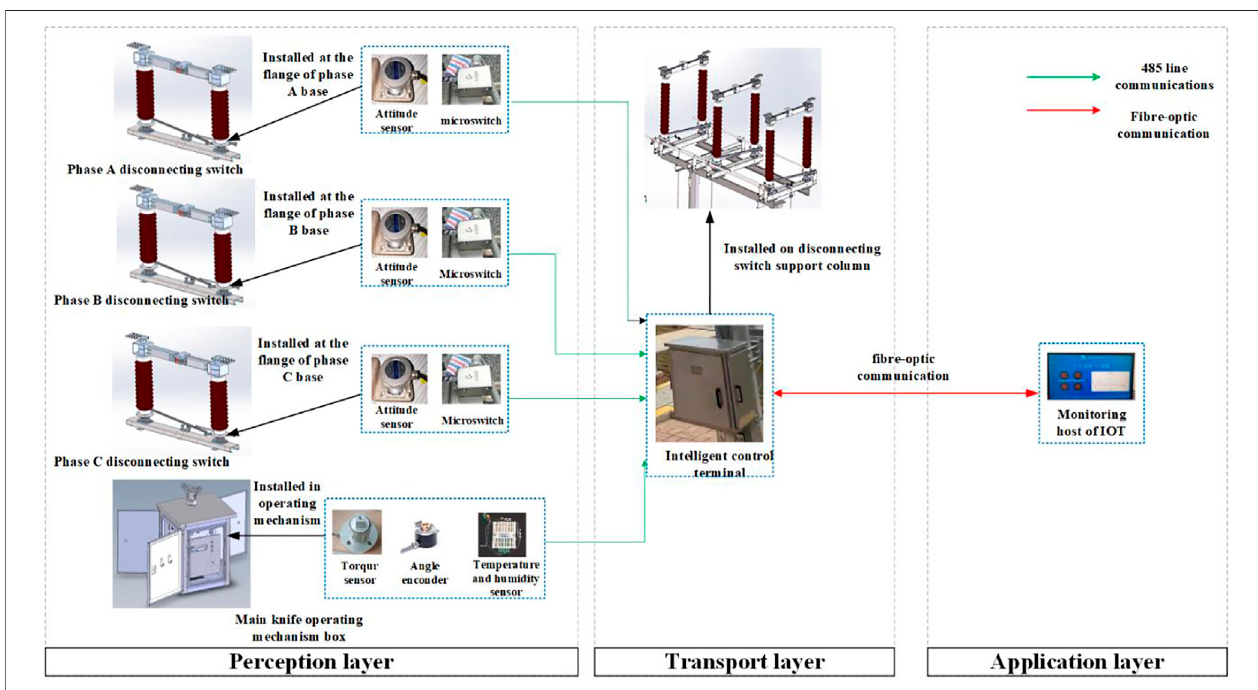
FIGURE 3 | Architecture of disconnector monitoring